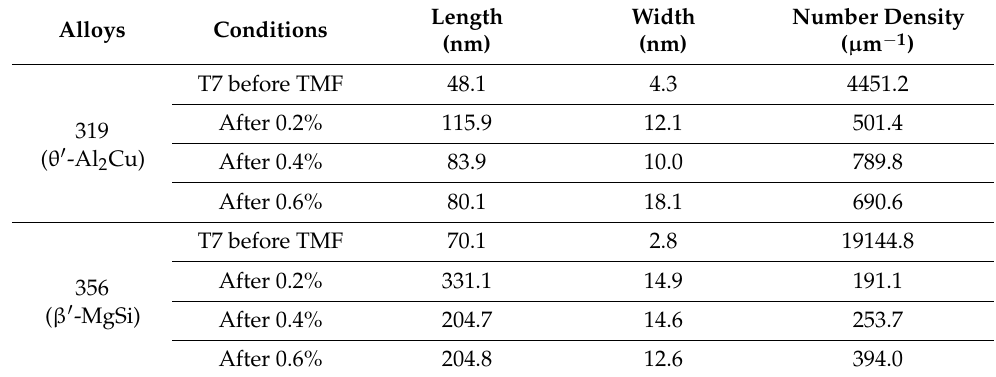
Table 5. Characteristics of precipitates of the alloys before and after TMF.